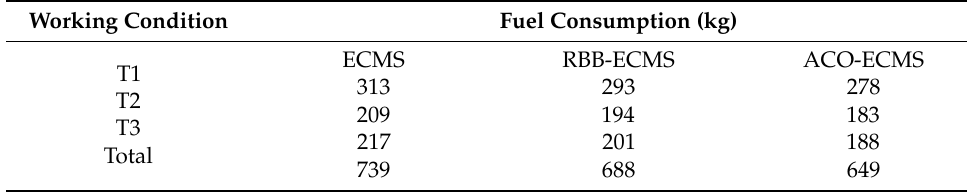
Table 2. Comparison of fuel economy for three methods. Working